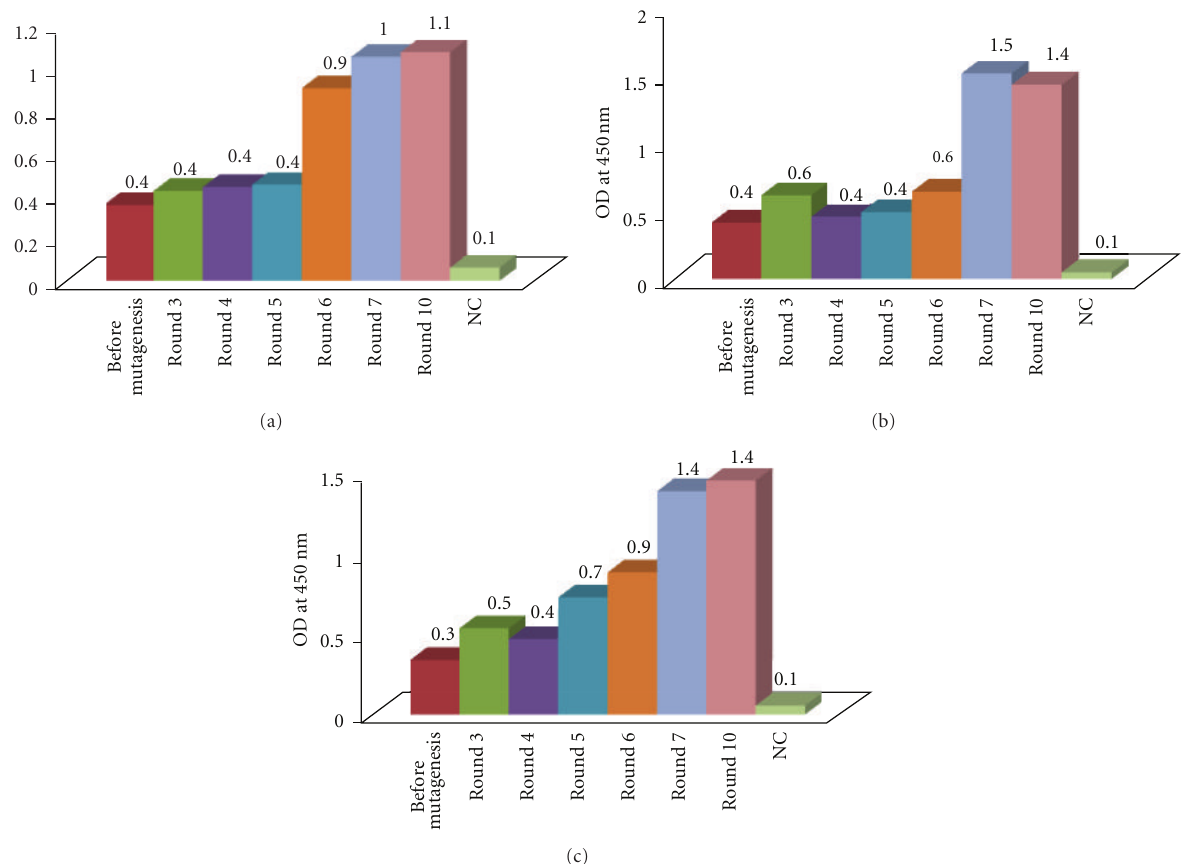
Figure 3: A ffi nity maturation of phages displaying Fab HCDR3 mutant of anti-MICA antibodies. After random mutagenesis of CDR3 of 3 anti-MICA phage display clones, they were selected against MICA by biopanning of ten rounds. Phage pools (10 8 pfu) of each round were tested for MICA binding by ELISA compared to the corresponding phages before mutagenesis (10 8 pfu). VCSM13 (10 8 pfu) was used as a negative control (NC). Comparative OD values of each round were shown in (a) WW2G8, (b) WW6B7, and (c) WW9B8. Apparently, the OD’s of selections after 7th round were not much increased. The final OD values were increased by 3–5-folds compared to the original clones. Thus, the pool phages of the 7th round were used to isolate individual phages with high binding activities indicated by OD